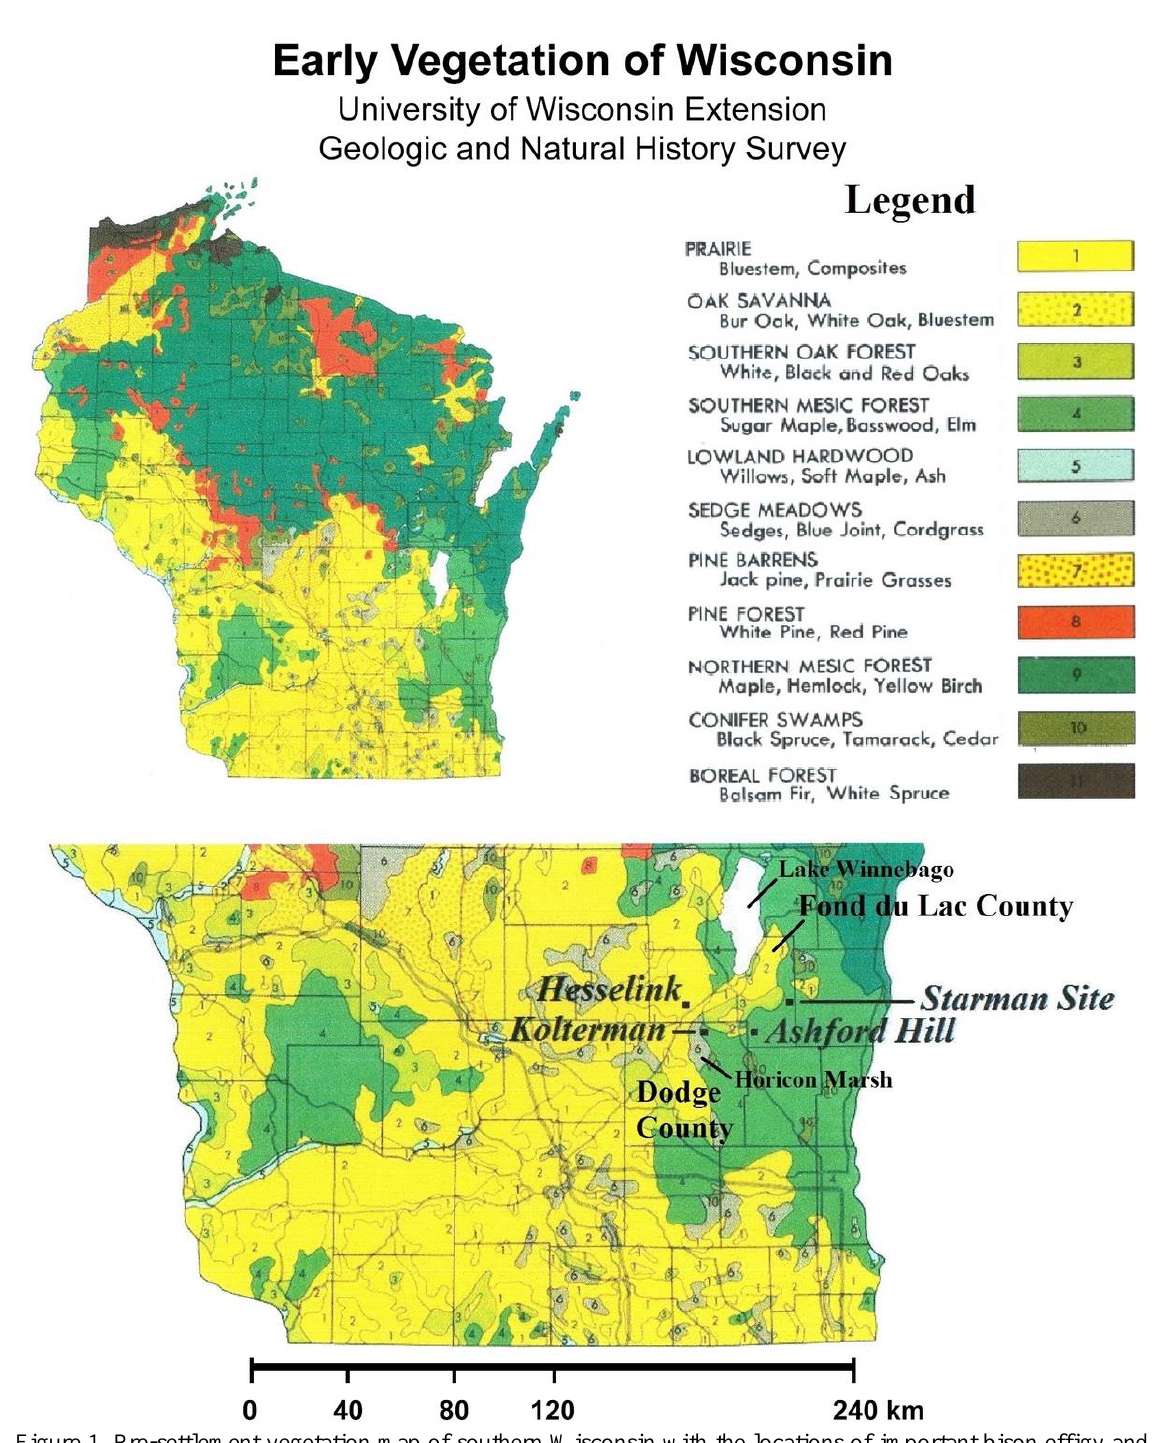
Figure 1. Pre-settlement vegetation map of southern Wisconsin with the locations of important bison effigy and petroform sites. Fond du Lac and Dodge Counties are marked. Note that the areas coloured yellow (Nos. 1 & 2) in the southern part of Wisconsin are prairie and oak savanna, both open grassland